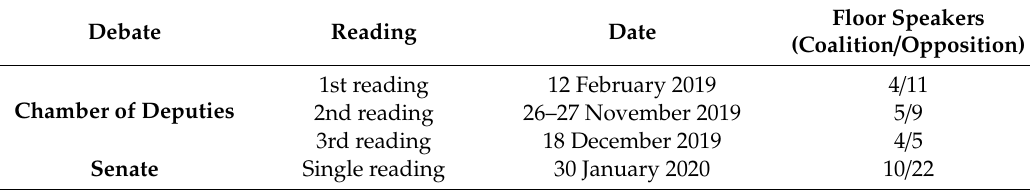
Table 1. The process of debating tougher criminal penalties in both chambers of the Czech parliament. Floor Speakers Debate Reading Date (Coalition / Opposition) 1st reading 12 February 2019 4 / 11 Chamber of Deputies 2nd reading 26–27 November 2019 5 / 9 3rd reading 18 December 2019 4 / 5 Senate Single reading 30 January 2020 10 / 22 Source: The Chamber of Deputies and the Senate, own